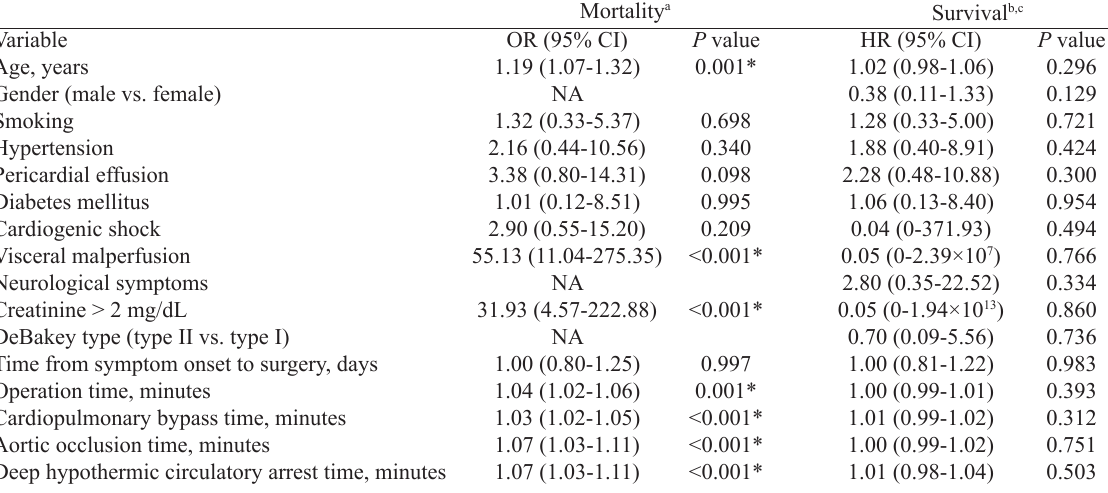
Table 4. Associations between demographic and clinical variables and mortality and survival during hospitalization (N=161). Variable